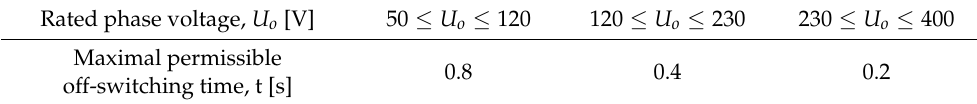
Table 1. The maximal permissible off-switching times—requirements according to [3].